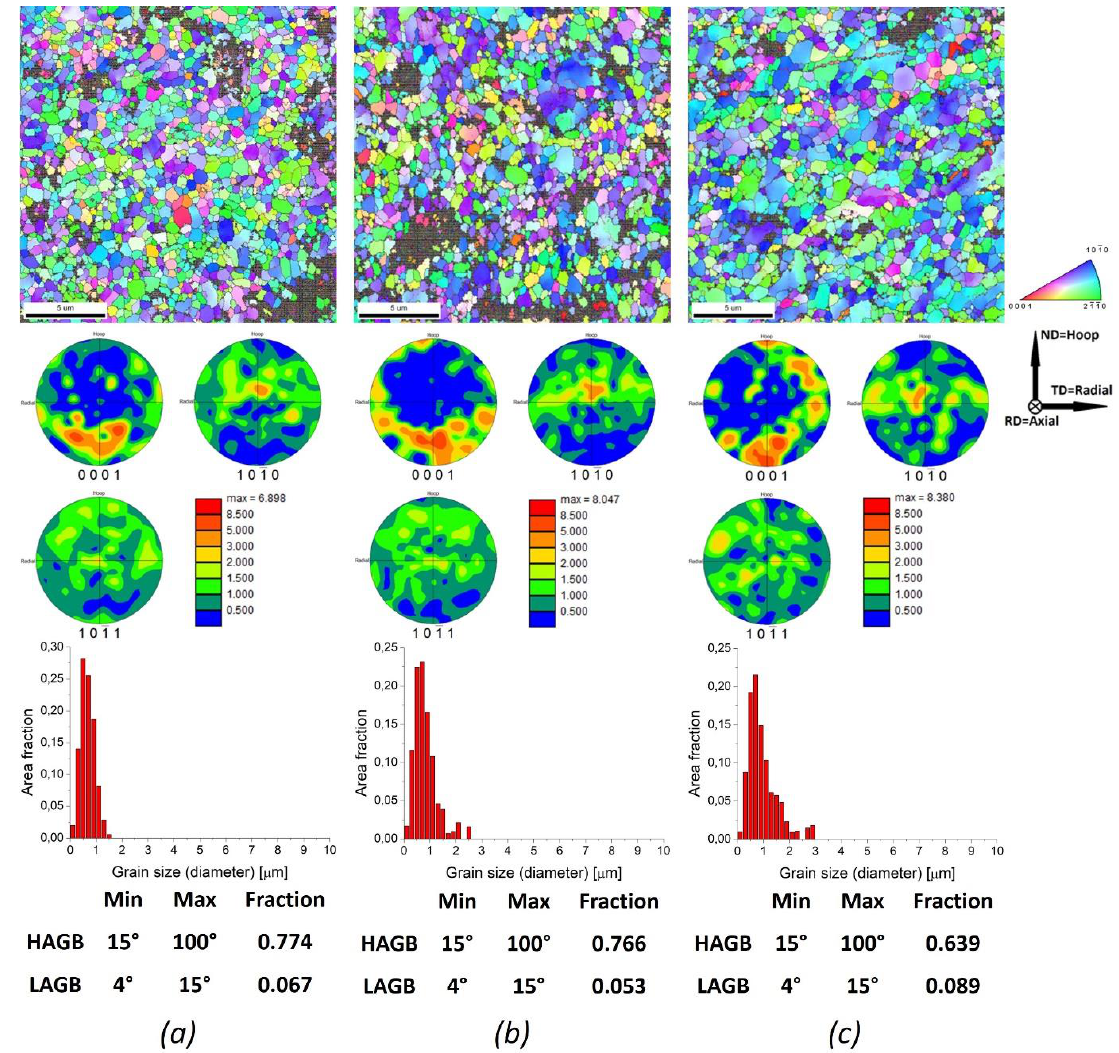
Figure 7. Grain orientation maps, local micro-textures, grain size distributions, and the HAGB and LAGB fractions of the sample after the third C-ECAP pass in the periphery ( a , c ), and in the center of the sample ( b ).